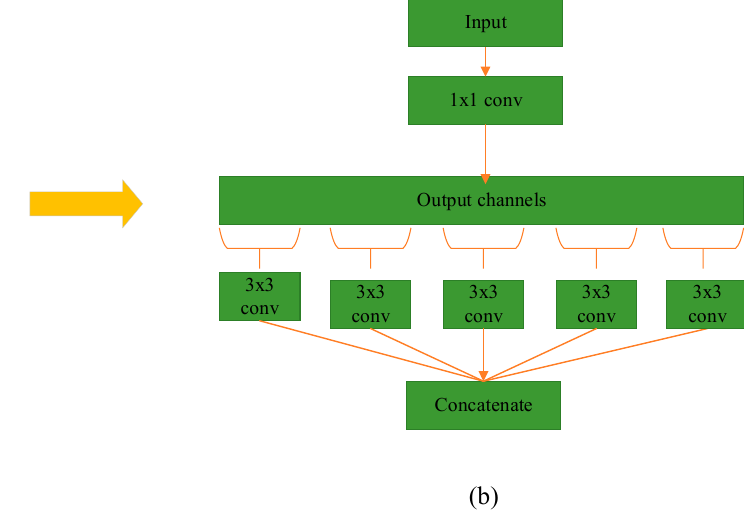
Figure 3. ( a ) Multi − channel convolution, ( b ) depth − wise separable convolutions.